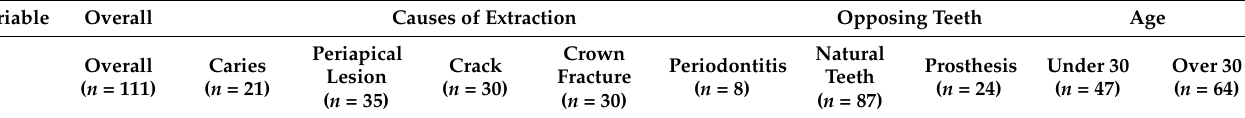
Table 3. Cumulative survival rate (%) based on multiple